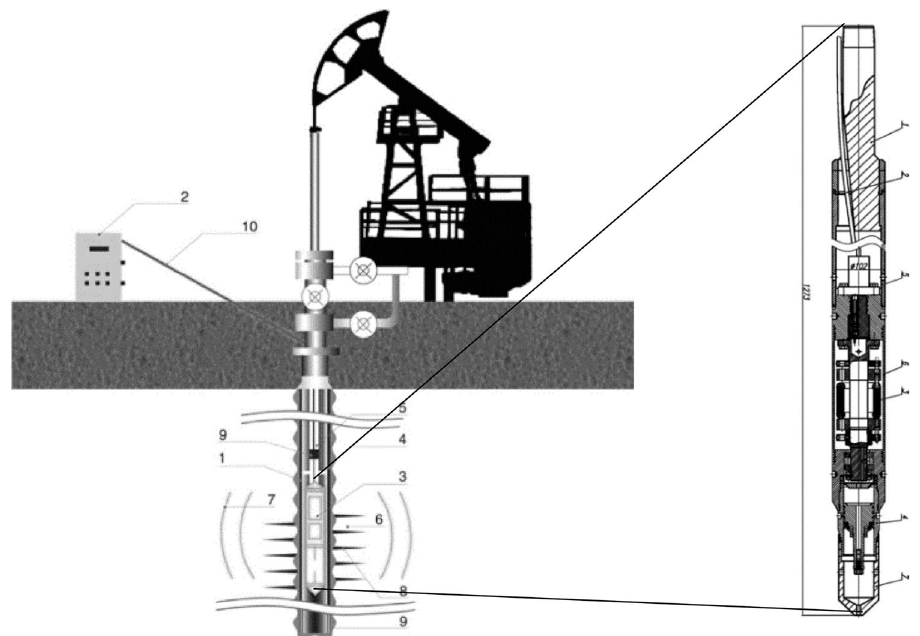
Fig. 5 Treatment of the near- wellbore area by the downhole tool PSMS-102. Adapted from (Mullakaev et al.